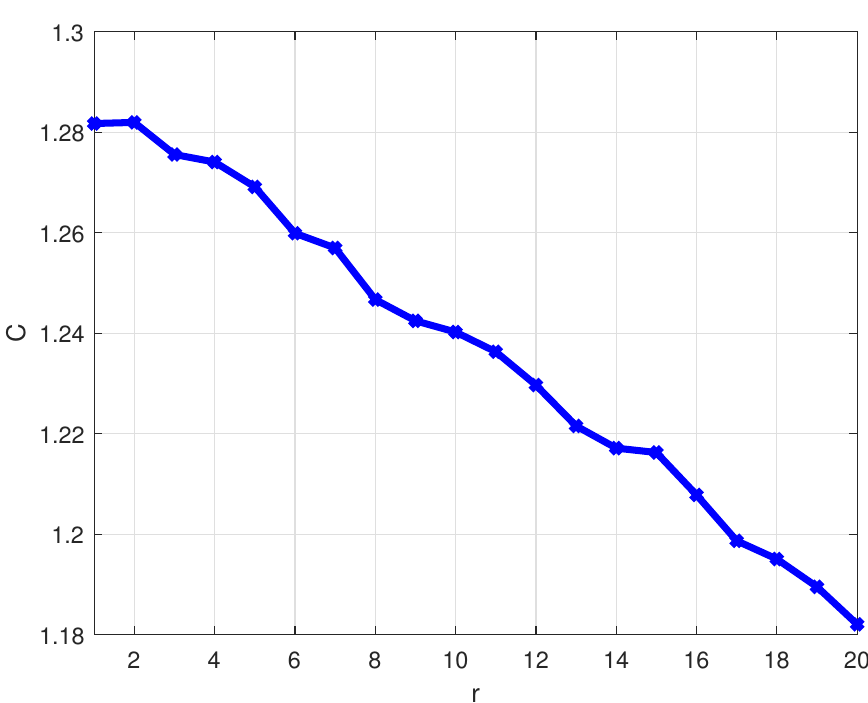
Figure 10. Task planning cost ratio C w.r.t. different period ratio r in the dynamic planning scenario. Figure 10. Task-planning cost ratio C with regard to different period ratios r in dynamic-planning There are 20 satellites with 5 clusters. The 200 objects are decomposed into 12 clusters. scenario. There were 20 satellites with 5 clusters. The 200 objects were decomposed into 12 clusters. Relative planning cost with regard to the number of objects is shown in Figure